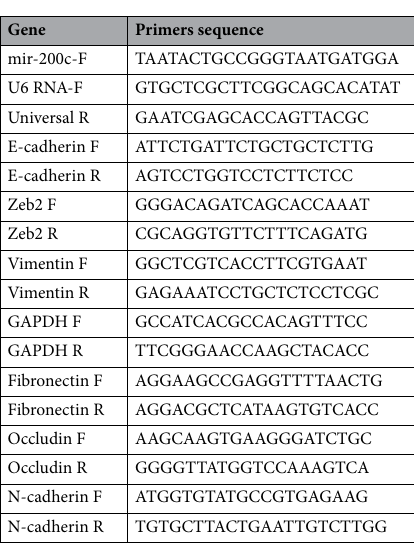
Table 1. Primer sets sequences used in quantitative real-time